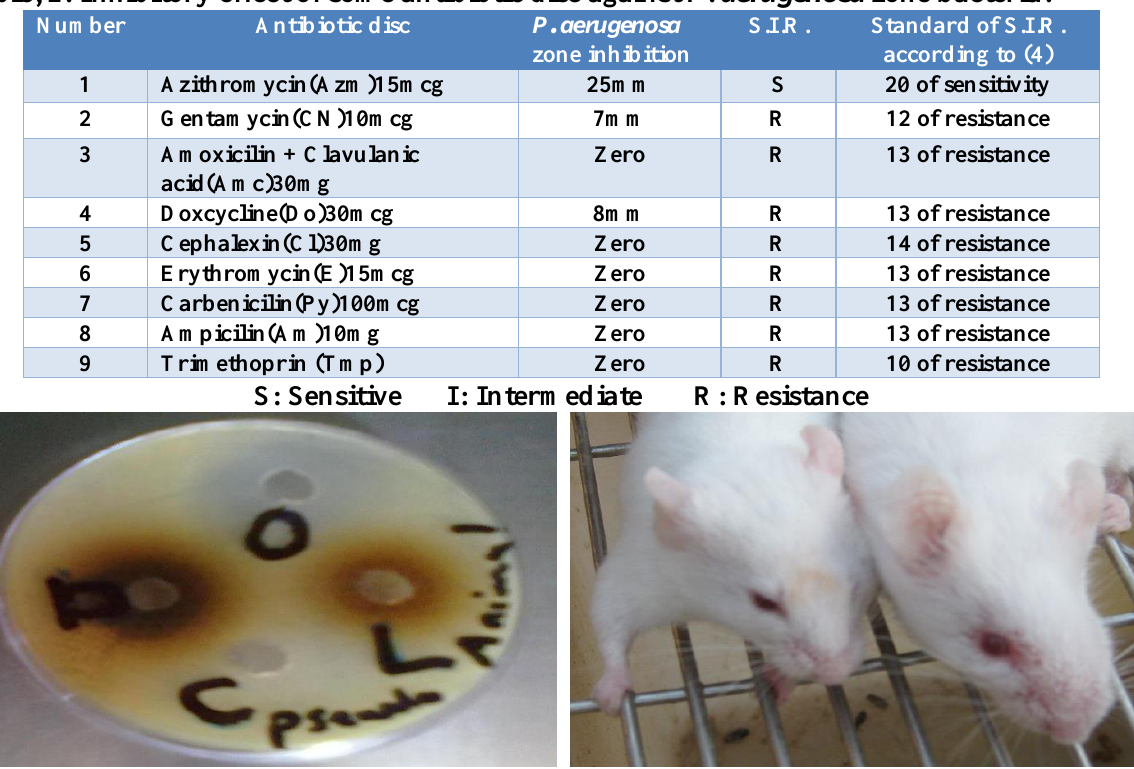
Figure, 1: Show the inhibitory effect of dandelion, lactobacillus and outocalm against Pseudomonas aerugenosa. D: dandelion, L: lactobacillus, O: Otucalm and C: control (alcohol).